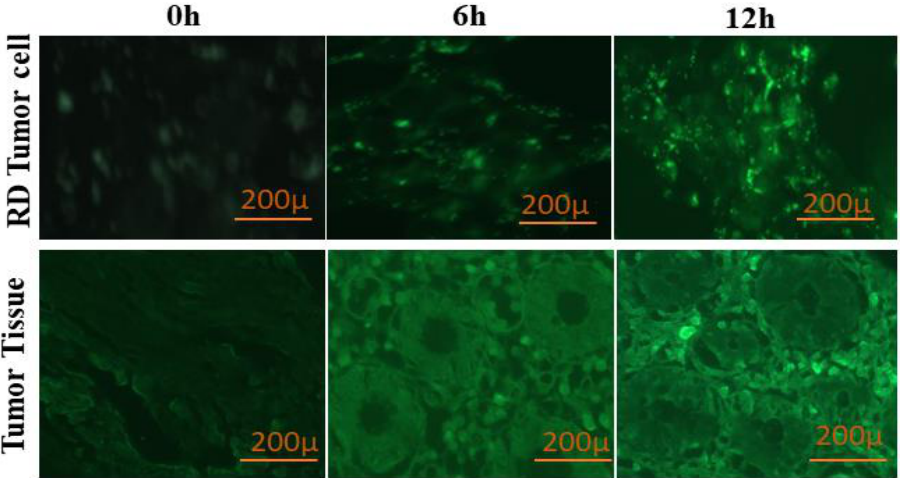
Figure 7. Internalization of curcumin (1.5 nM) in HCT-116 cells and tumor tissues for 0, 6, and 12 h by inhibition of the P-gP efflux pump.